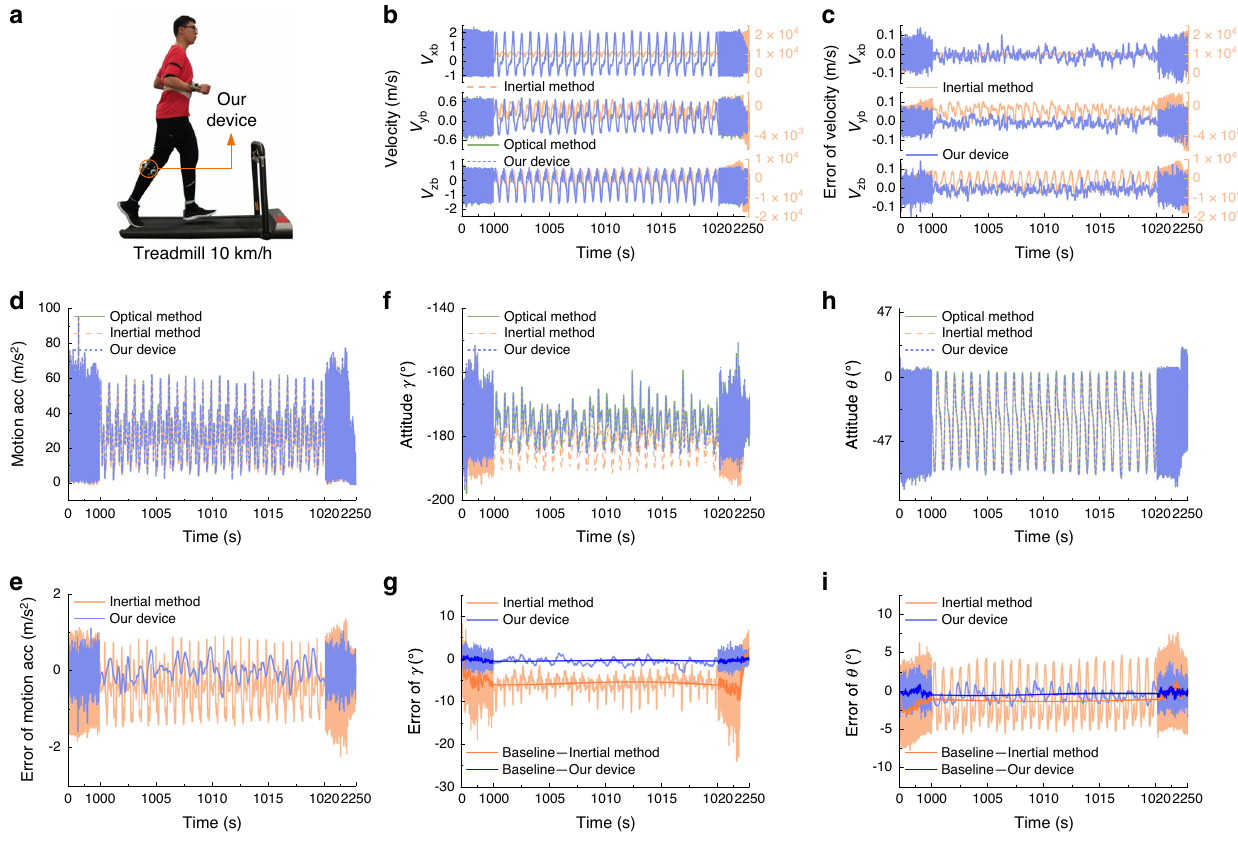
Fig. 6 Long-time motion capture and velocity measurement results. a The subject wearing a device on his shank keeps running on a treadmill at the speed of 10 km/h for about 30 min and then gradually stop for another 7 min. b – c The tri-axis motion velocity measured by our device and inertial method, respectively ( b ), and the corresponding errors ( c ). d – e The magnitude of motion acceleration measured by our device and inertial method, respectively ( d ), and the corresponding errors ( e ). High dynamic motion with motion acceleration more than 70 m/s 2 is observed. f – i The attitude estimation results of roll angle γ ( f ) and pitch angle θ ( h ), respectively, and the corresponding attitude errors by our device and inertial method, respectively ( g and i ). Motion capture results of optical VICON system are used as reference